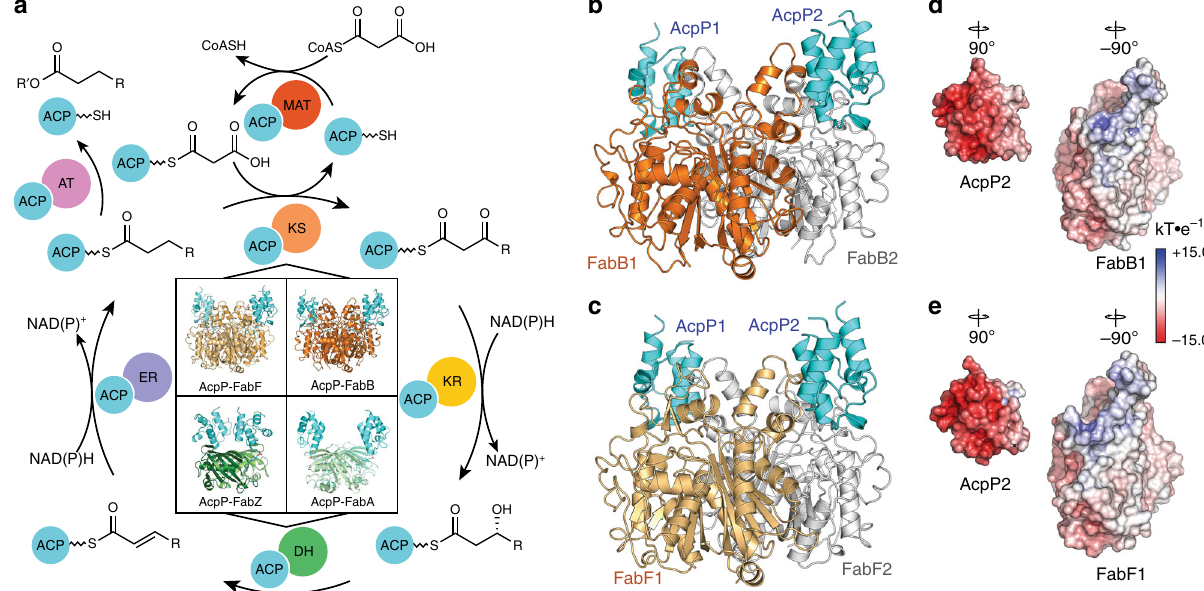
Fig. 1 FAB cycle and known AcpP – PP complexes. a A schematic representation of the chemical transformations that occur during fatty acid biosynthesis, highlighting the importance of protein – protein interactions required at each step for substrate processing. The four quadrants at the center of the scheme show the structures of all FAS AcpP crosslinked complexes solved thus far. The top two structures are the crosslinked AcpP – KSs (AcpP – FabF and AcpP – FabB) reported herein, while depicted below are the crosslinked AcpP – DHs (AcpP – FabZ and AcpP – FabA) solved and reported in previous publications 14,33 . Each domain is abbreviated as follows: MAT malonyl-ACP transacylase, KS ketosynthase, KR ketoreductase, DH dehydratase, ER enoylreductase, and AT acyl transferase. AcpP-DH structures depicted in bottom two quadrants are AcpP – FabZ (PDB: 6N3P), AcpP – FabA (PDB: 4KEH). b , c Cartoon representations of the crosslinked AcpP – FabB and AcpP – FabF dimers. AcpP is colored cyan; the fi rst KS monomer of AcpP – FabB and AcpP- FabF is colored orange or light orange, respectively, while the second is colored white in both structures. d Electrostatic potentials (ESP) maps of the FabB and AcpP monomers. e ESP maps of the FabF and AcpP monomers. In all cases, the ESP is mapped onto the Connelly surfaces of the FabF and AcpP monomers using a blue to white to red color range, spanning from + 15.0 kT·e – 1 to – 15.0 kT·e – 1